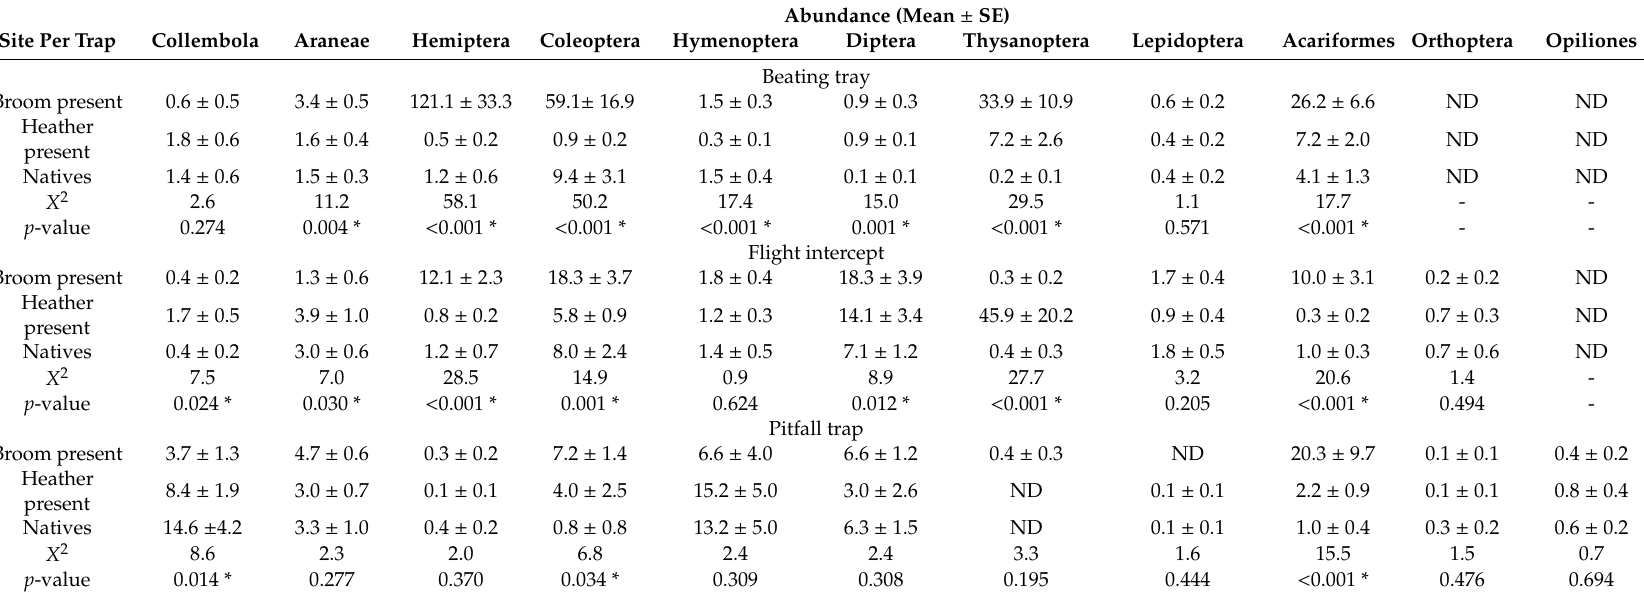
Table 1. The most abundant arthropod orders found at weed-invaded and non-invaded sites in summer. Comparisons between sites were performed using a negative binomial generalised linear model. Site was the predictor, while arthropod groups were used as the response variables. The likelihood ratio test was used to assess the significance of the